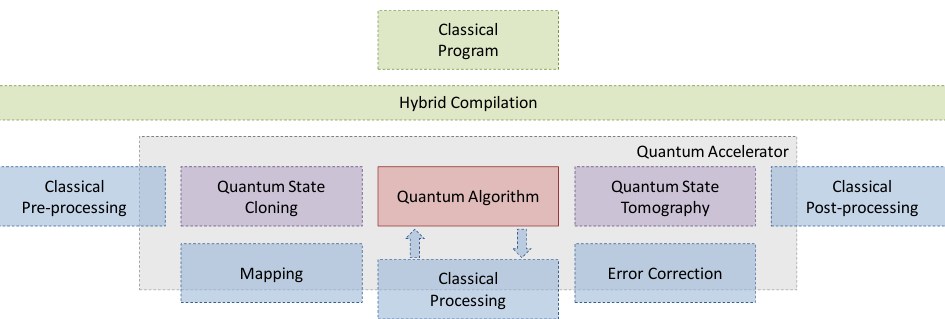
Figure 8. Quantum Algorithm (block with solid outline) and interfacing software